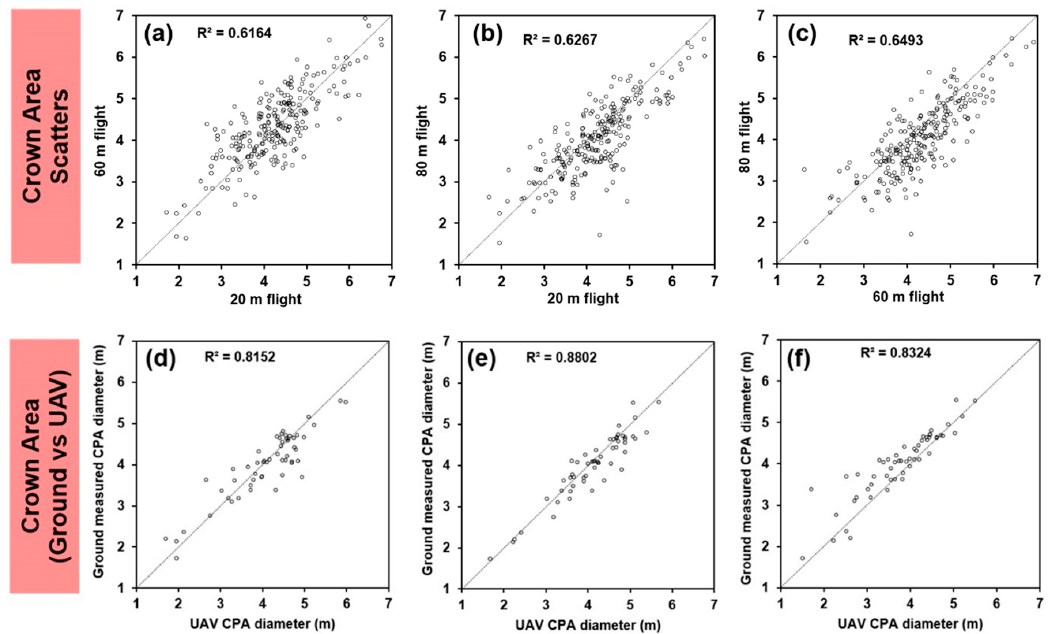
Figure 9. Scatterplot to compare crown projected area (CPA) diameter measured from different altitudes: ( a ) 20 m and 60 m, ( b ) 20 m and 80 m, and ( c ) 60 m and 80 m. A plot between ground measured CPA and UAV estimated CPA at flight altitude of ( d ) 20 m, ( e ) 60 m, and ( f ) 80 m.